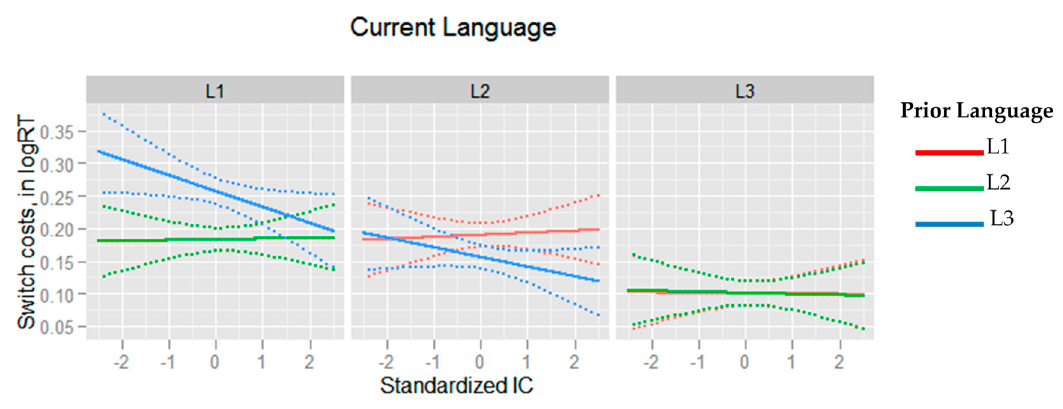
Figure 2. Relationship between inhibitory control and language switch costs (in log RT) by the language on the current trial. A larger standardized inhibitory control (IC) score indicates better inhibitory control abilities. Dotted lines indicate 95% confidence bands.